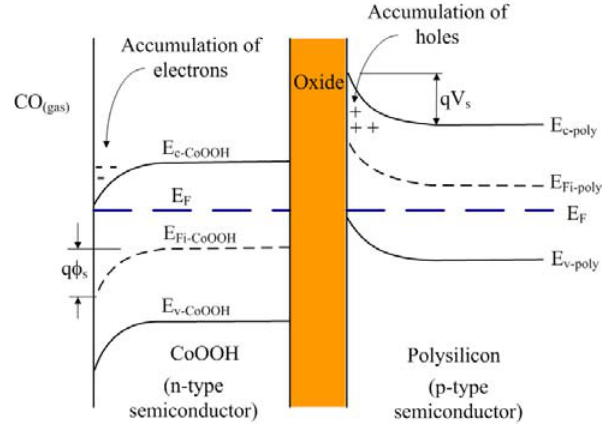
Figure 4. Energy band diagram of the CO sensor. E conduction band of CoOOH, E intrinsic Fermi level of CoOOH, E valence band of polysilicon, E charge,   is negative surface potential and V s